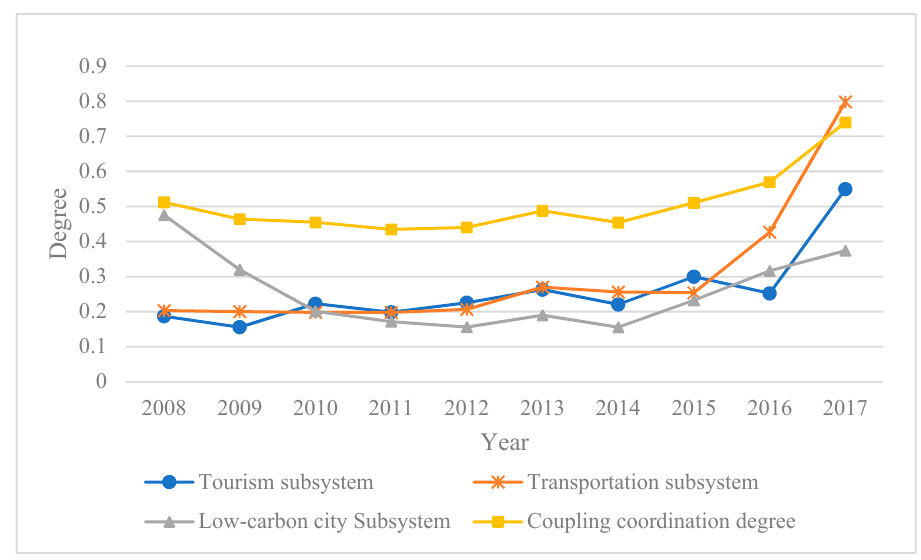
Figure 6. Coupling and coordination degree of Chongqing’s TTLC systems from 2008 to 2017.